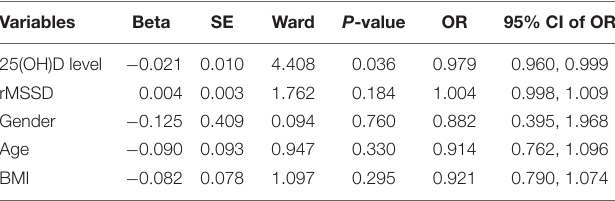
TABLE 4 | Logistic regression analysis between non-dipper blood pressure and serum 25(OH)D level, rMSSD, gender, age, and